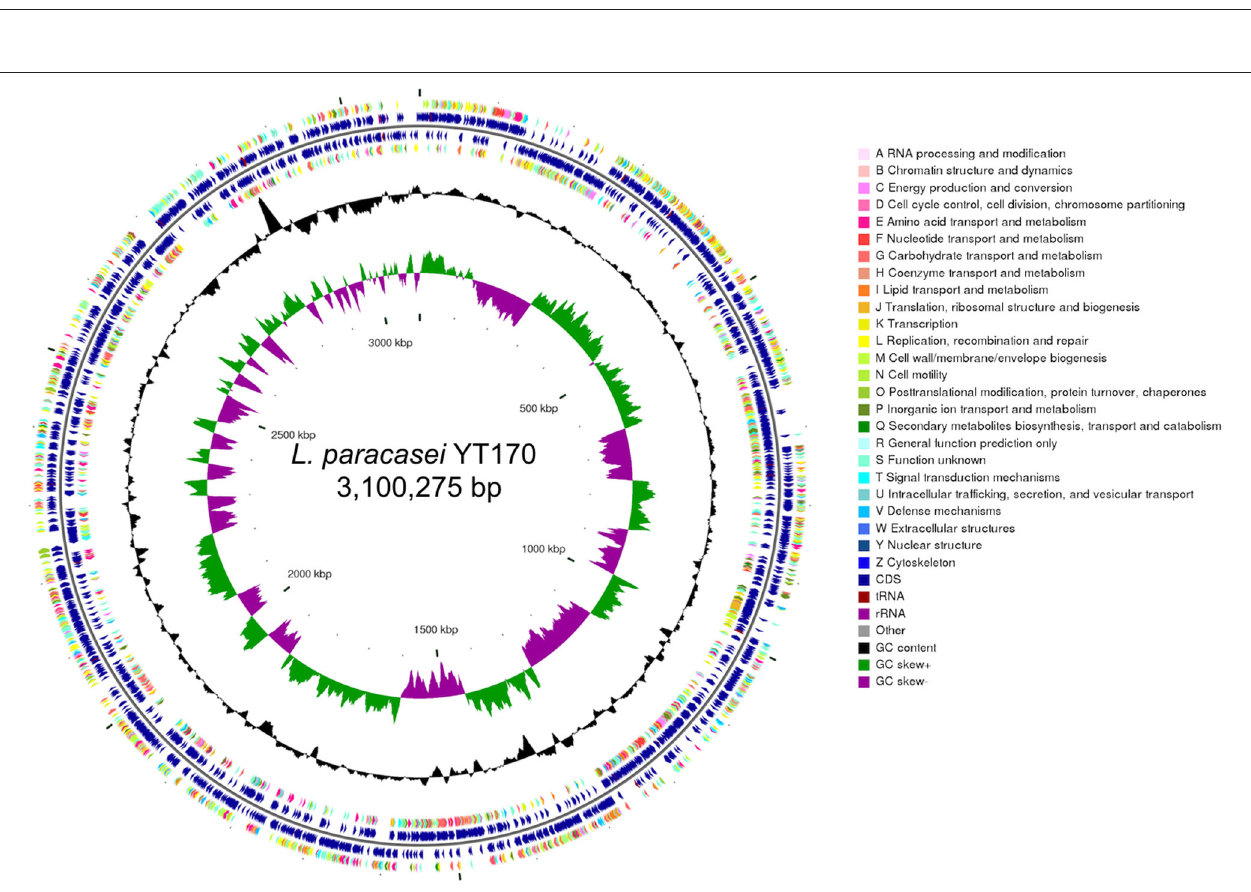
FIGURE 4 | Genome features of L. paracasei YT170. circular genomic map of L. paracasei YT170. The circular map was generated using CGview and contains seven circles. From the inner circle to the outer ring: The first lap depicts the location of the genome. The second lap shows the GC skew (G + C/G–C), which the value is plotted as the deviation from the average GC skew of the complete sequence. The third lap shows GC content. The 5th (forward strand) and 6th lap (reverse strand) indicate the sites of CDSs/rRNA/tRNA on the genome. The 4th (forward strand) and 7th lap (reverse strand) illustrate the CDSs, colored according to COG function